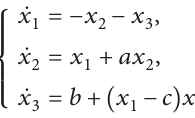
. 0. (b) α . 5. (c) α . 0. (d) α . 2 (cid:31) 1 2 (cid:31) 1 2 (cid:31) 2 2 (cid:31) 2